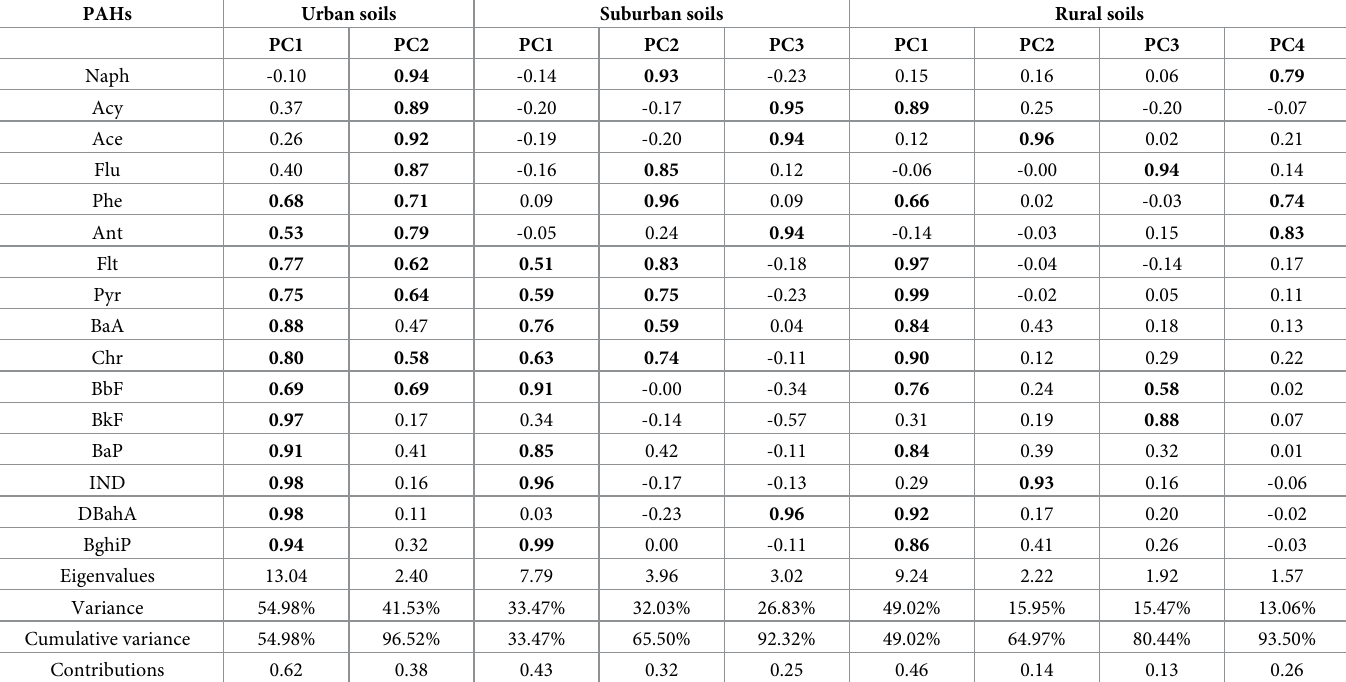
Table 4. The total variance explained and component matrix of PAHs in different land use types in Beijing and